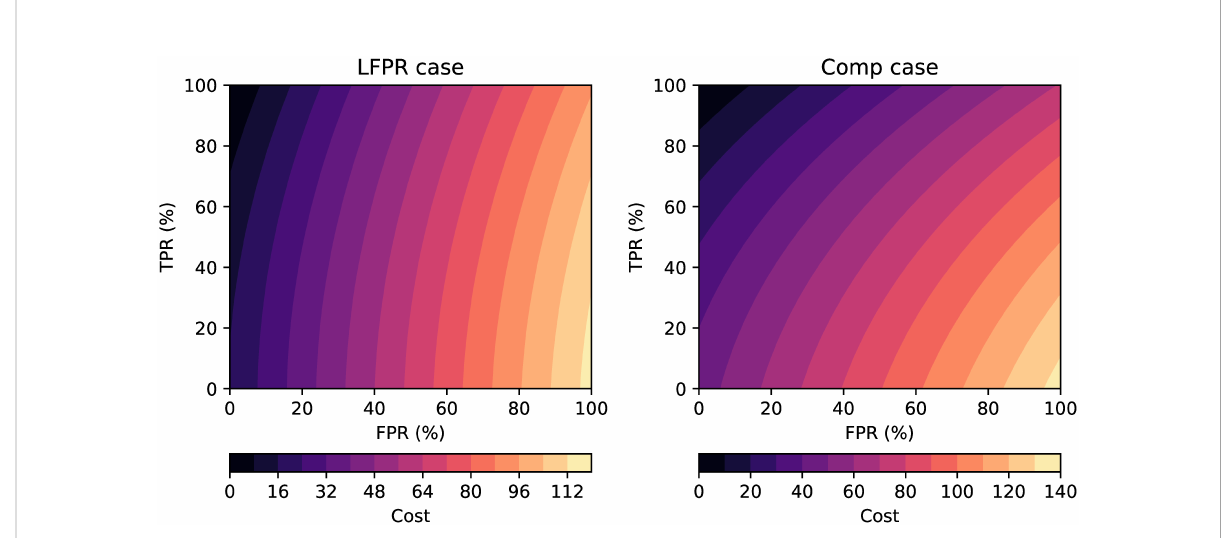
FIGURE 1 Values of the cost function used to generate optimal sets of QC checks in the LFPR and Comp